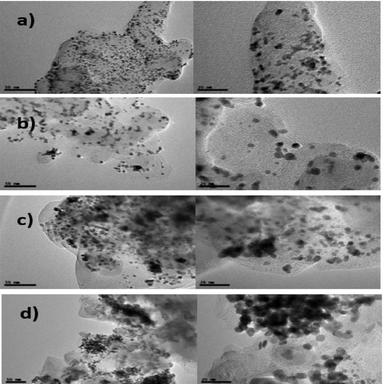
TEM images of the different catalysts. a) Commercial Pt/C, b) Lab-Made Pt/C, c) Pt/(Si0.9Ti0.1)C and d) Pt/(Si0.8Ti0.2)C.